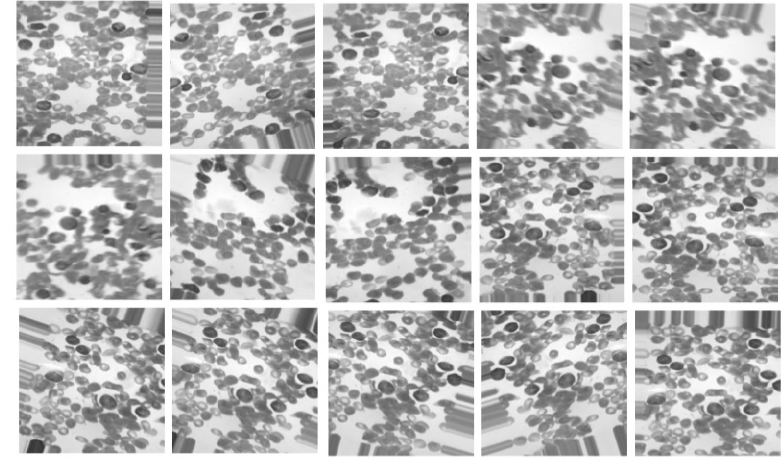
Figure 4. The artificial images created by the GAN for the ALL group.